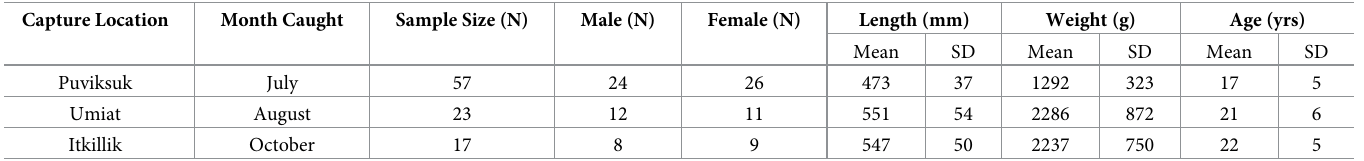
Table 1. Summary of otoliths collected from Broad Whitefish ( Coregonus nasus ) caught in the Colville River, AK, USA. Capture